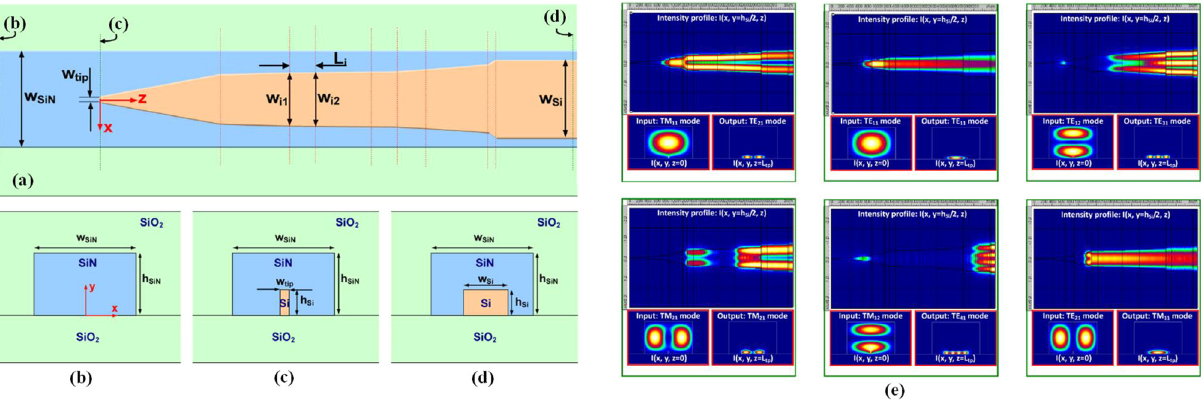
Figure 21: (a) Schematic of a mode multiplexer using a grating coupler array and (b) its generated modes observed after transmission through a 5-m long FMF that supportsonly LP 01 andLP 11 modes[244]. (c) Schematic of a 2D grating coupler – based multiplexer and (d) its generated mode pro fi les measured after fi ber transmission [245]. FMF, few-mode fi ber.